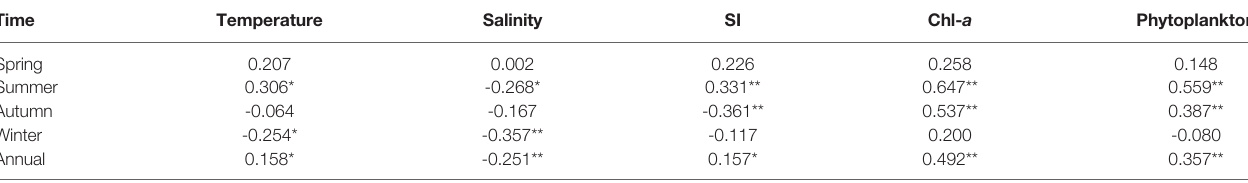
TABLE 3 | Correlation coef fi cients (Spearman ’ s r ) between the depth-integrated abundance of N.scintillans and environmental factors in the East China Sea and southern Yellow Sea. Time Temperature Salinity SI Chl- a Phytoplankton Spring